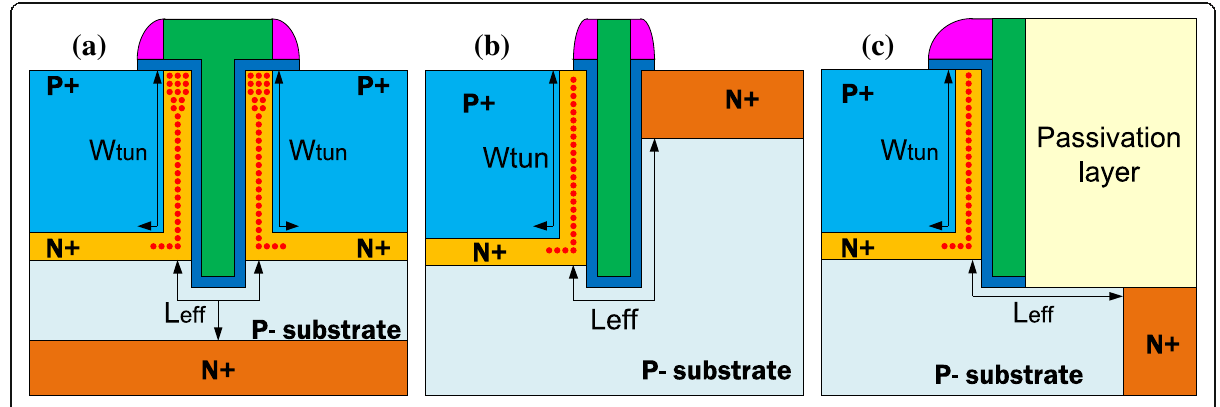
Fig. 2 Comparison of a the proposed TGTFET, b UTFET, and c LTFET